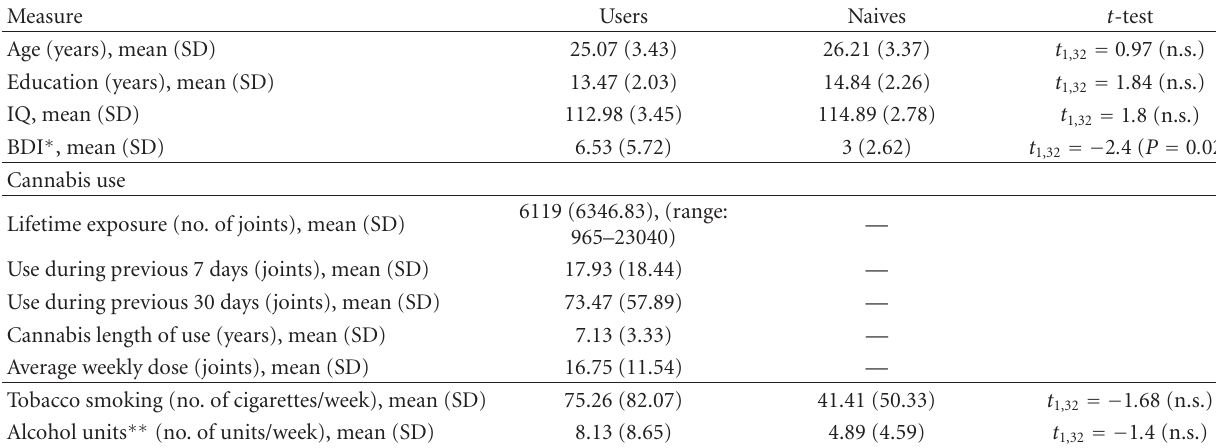
Table 1: Participants’ demographic information and drug